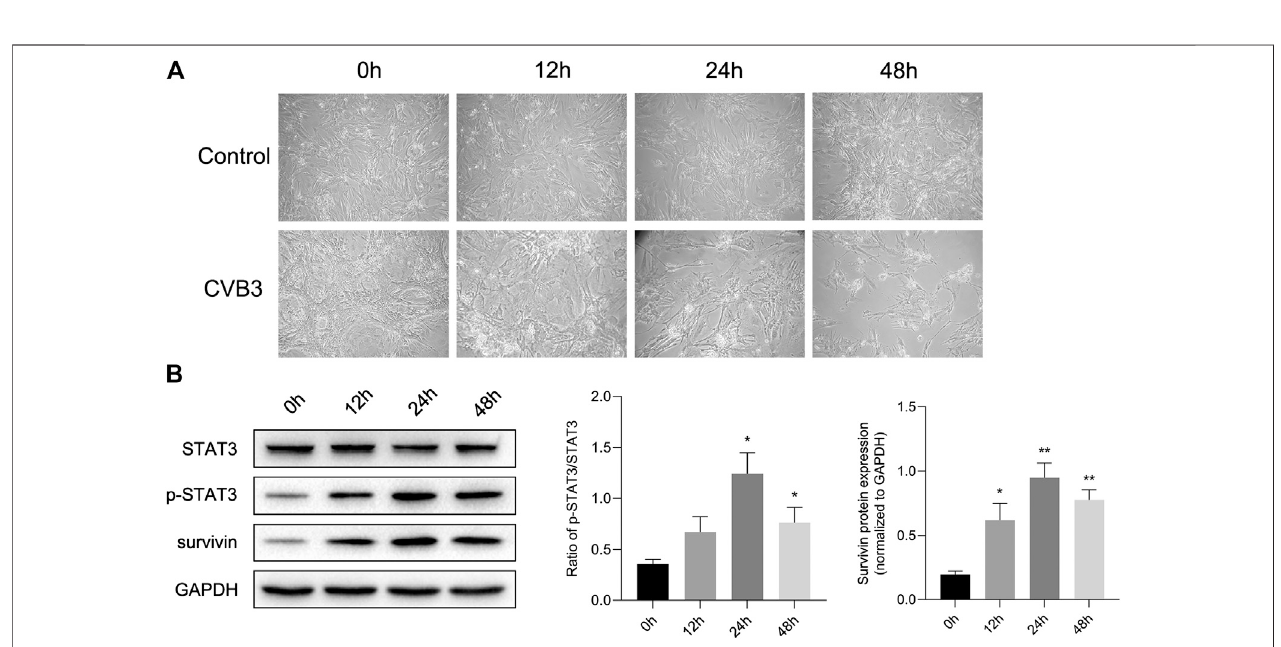
FIGURE 2 | STAT3 was activated in viral myocarditis cell model. NMCs were infected with CVB3 and the proteins were collected at different time point (A) The morphologicalchangesofNMCat0,12,24,and48 hafterCVB3infection(200 × ) (B) Therelatedproteinsweremeasuredbywesternblot( n (cid:2) 4).* p < 0.05,** p < 0.01vs control group (NC).